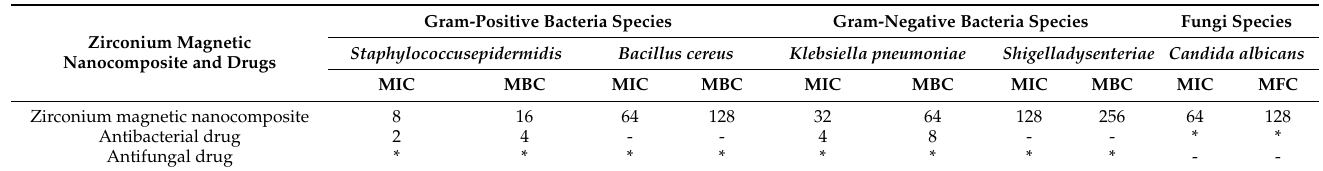
Table 4. Results of antibacterial and antifungal activity of zirconium magnetic nanocomposite compared to commercial